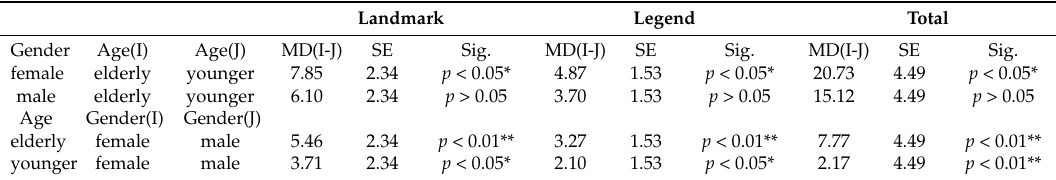
Table 6. Simple Effects Test for Task 2 (route